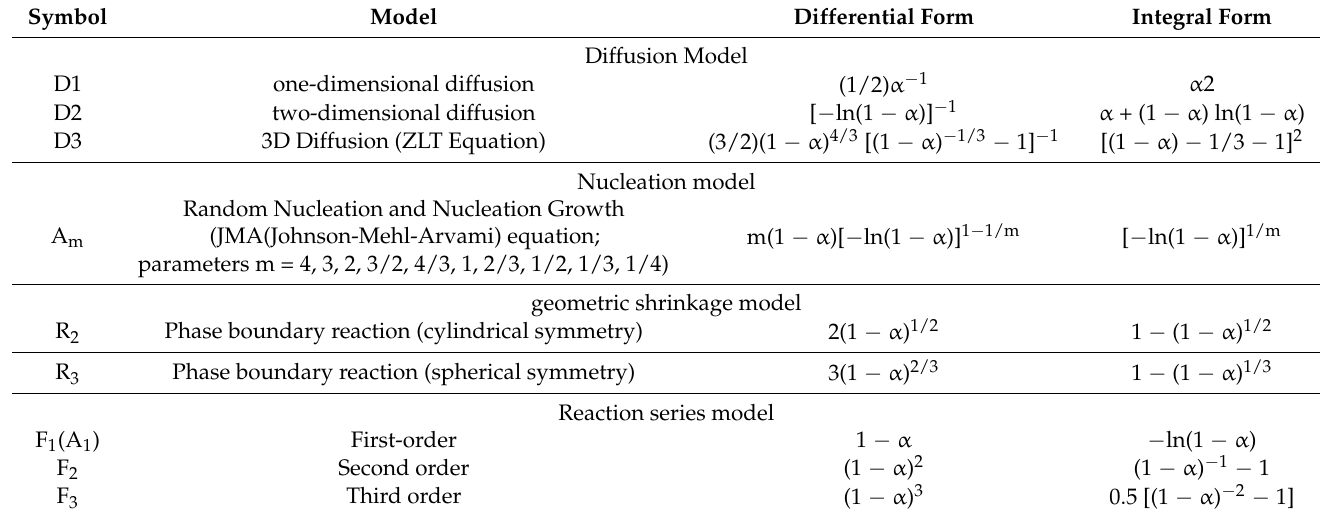
Table 1. Common mechanism function